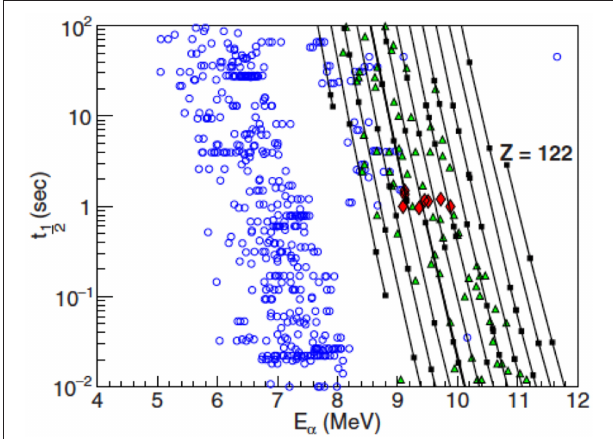
FIGURE 2 | A plot of t 1 / 2 vs. E α for coincident pairs of TLFs from the 238 U + 232 Th reaction from Wuenschel et al. [78]. Open circles denote Z ≤ 101 and filled triangles indicate Z ≥ 101. The lines and filled squares indicate the